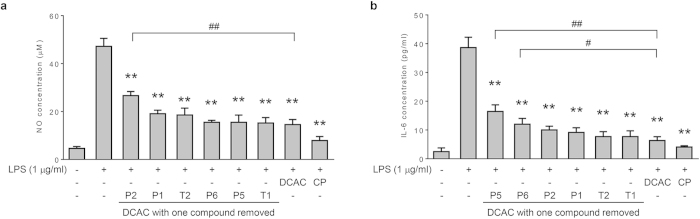
Effects of compound removal on the anti-inflammatory activity of DCAC.Cells were pretreated with tested samples (at a corresponding concentration in 0.4 mg/ml CP) for 1 h, followed by treatment with LPS (1 μg/ml) and incubation for 24 h. (a) NO and (b) IL-6 concentration in the supernatants of macrophages treated by DCAC with each compound removed respectively. Data are presented as mean ± SD of three independent experiments. **p < 0.01 versus LPS group; #p < 0.05, ##p < 0.01 versus DCAC group (one-way ANOVA, Dunnett test). CP: Cardiotonic Pill; DCAC: dominant combination of anti-inflammatory compounds; P1: danshensu, P2: protocatechuic aldehyde; P5: isolithospermic acid A; P6: salvianolic acid A; T1: tanshinone I; T2: dihydrotanshinone I.